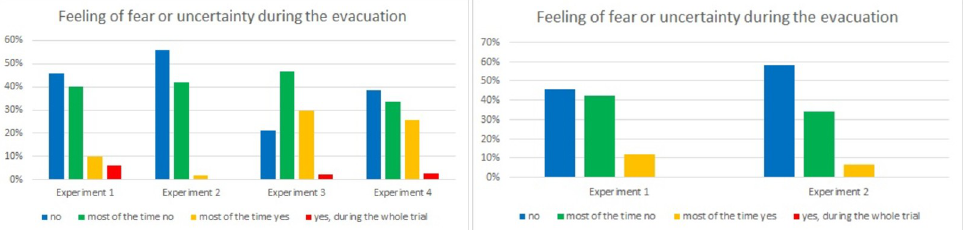
Fig 12. Feeling of fear or uncertainty among evacuees during consecutive experiments–question 3. (Results from Laliki experiment are on the left; results from Gda ń sk are on the right).